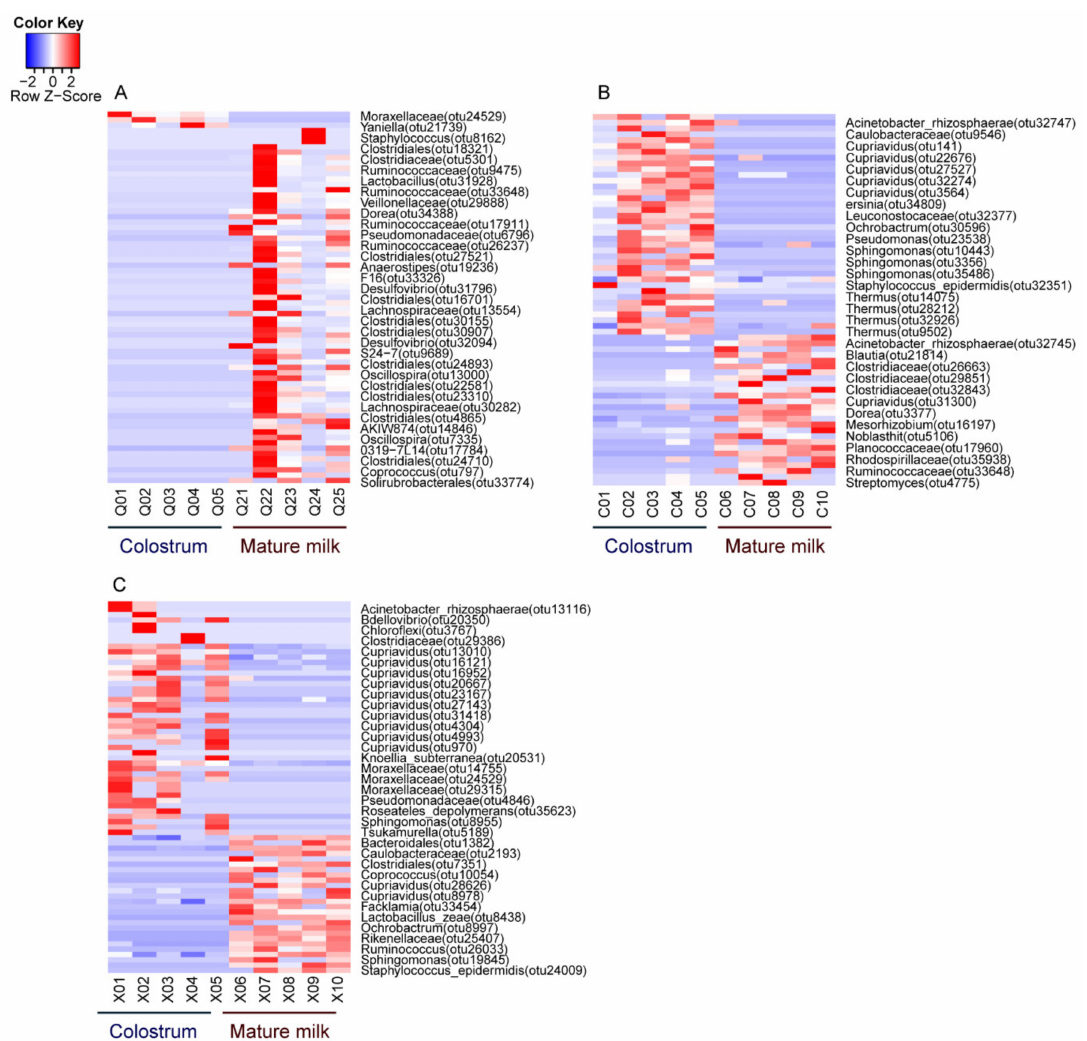
Figure 4. The relative abundance of the top genera between colostrum and mature milk from three farms. The genera with relatively high values are represented in red (0–2) and low values in blue (0–( − 2)). Goat milk microbiota composition at genus level was significantly di ff erent between the colostrum and mature milk in three farms ( A – C